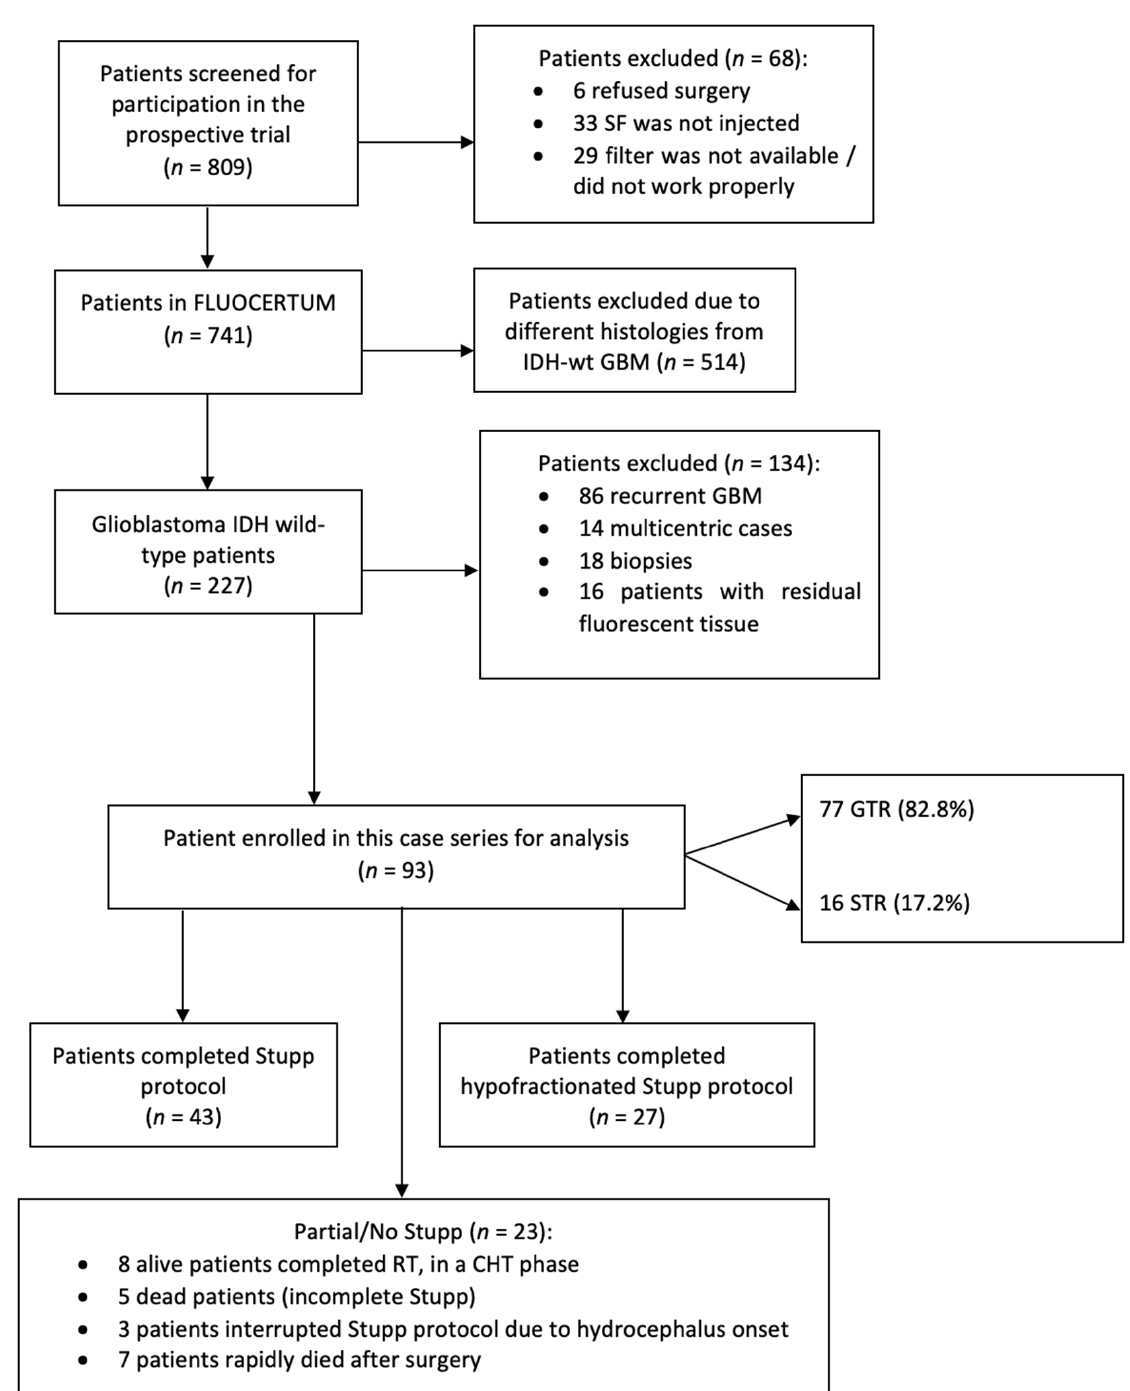
Figure 1. Flow diagram of patients’ enrollment and management.